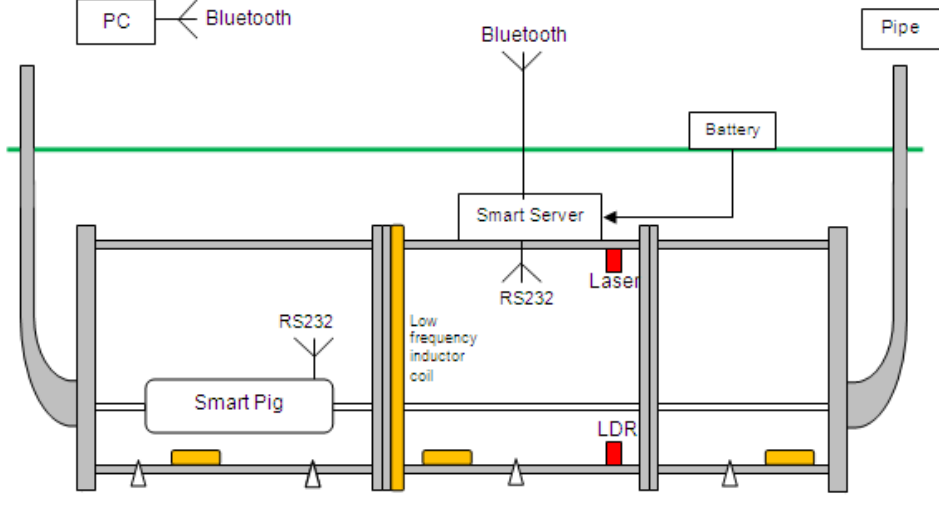
Figure 1. Schematic arrangement of the smart pipe demonstrator unit [29].